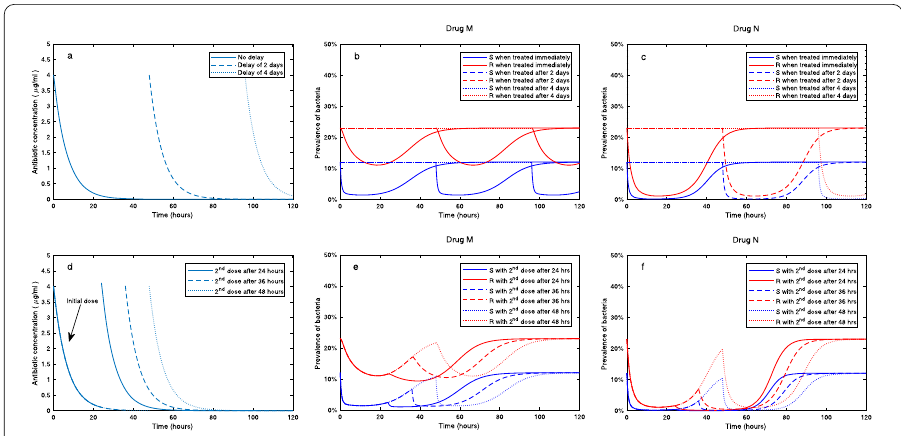
Figure 6 Effectsofdelaysindrugadministration . ( a ) Antibiotic concentration changes according to time for three scenarios of a delay in administering an initial dose of a therapeutic agent: (1) no delay (2) delay of two days, and (3) delay of four days. ( b )–( c ) Prevalence of sensitive and resistant bacteria after administering drug M and N, respectively. ( d ) When there is a delay in administering the second dose of an antimicrobial agent, the antimicrobial concentration changes with time according to three scenarios: (1) no delay in the second dose, (2) delay of 12 hours, and (3) delay of 24 hours. ( e )–( f ) Prevalence of sensitive and resistant bacteria when there is a delay in administrating the second dose for drug M and N, respectively ( S (0) = 1.2 × 10 8 and R (0) = 2.3 × 10 8 )